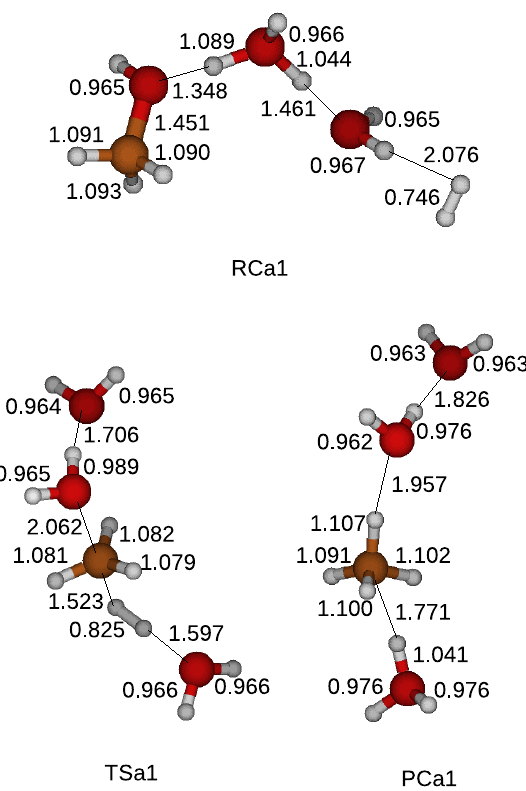
Figure 6. Calculated geometries of a reactant compound (RCa1), a transition state (TSa1), and a product compound (PCa1) for the acid catalyzed reduction of a methanol. A hydronium and a water molecule were introduced in the